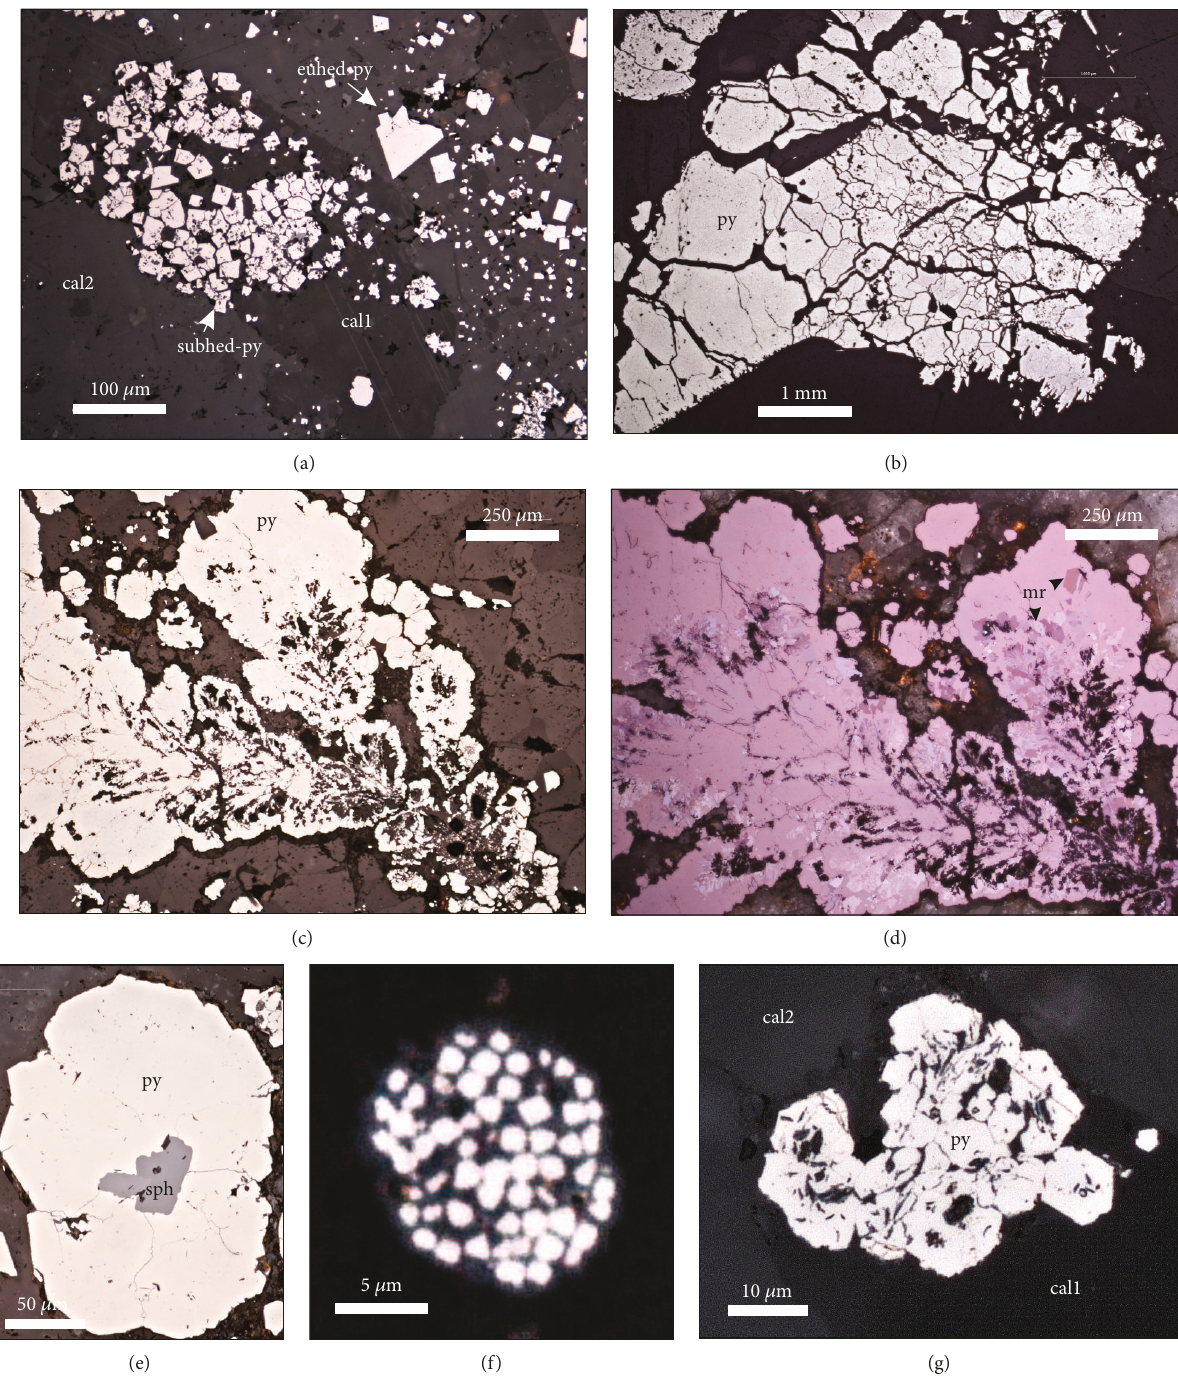
Figure 8: Re fl ected light photomicrographs summarizing textural and compositional characteristics of sul fi des in vein margins associated with vein carbonates and laminated sedimentary wall rocks. (a) Recrystallized (former framboids) subhedral pyrite (subhed-py) in early brown carbonate ( “ cal 1 ” ) surrounded in later carbonate ( “ cal 2 ” ) containing euhedral pyrite (euhed-py). (b) Cataclastic pyrite in wall rock. (c-d) Plumose, porous, pyrite-marcasite intergrowths showing massive domains of pyrite alternating with polycrystalline domains of marcasite. (d) Same area as (c) but in crossed nicols to emphasize anisotropy of marcasite; enclosed dark material is calcite. Dark areas within pyrite-marcasite intergrowths are porosity. (e) Subhedral pyrite polycrystalline aggregate with sphalerite core. (f) Pyrite framboid in black layer of “ zebra ” rock (Figure 7(g)). (g) Recrystallised pyrite (former framboid) along vein-wallrock margin enclosed within early brown carbonate domain ( “ cal 1 ”